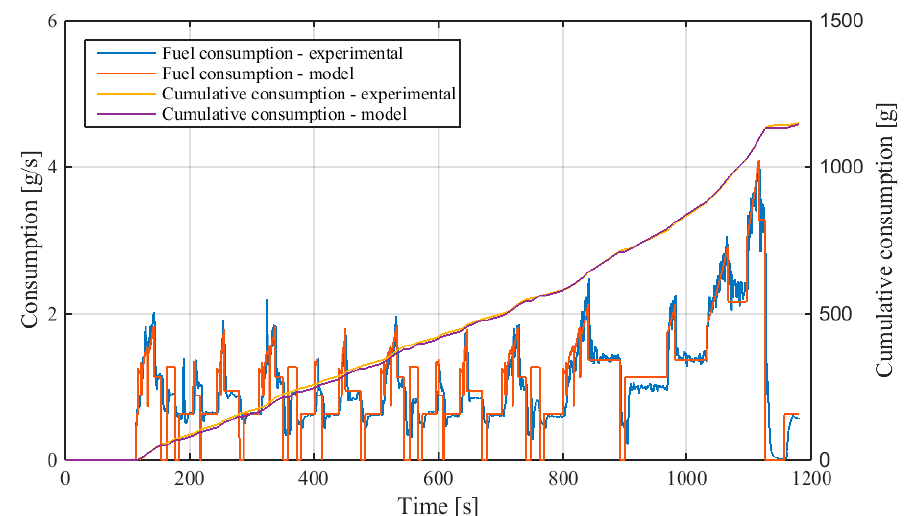
Figure 6. Comparison between experimental and simulation fuel consumption results for the case study vehicle equipped with the DCT, along the New European Driving Cycle (NEDC).